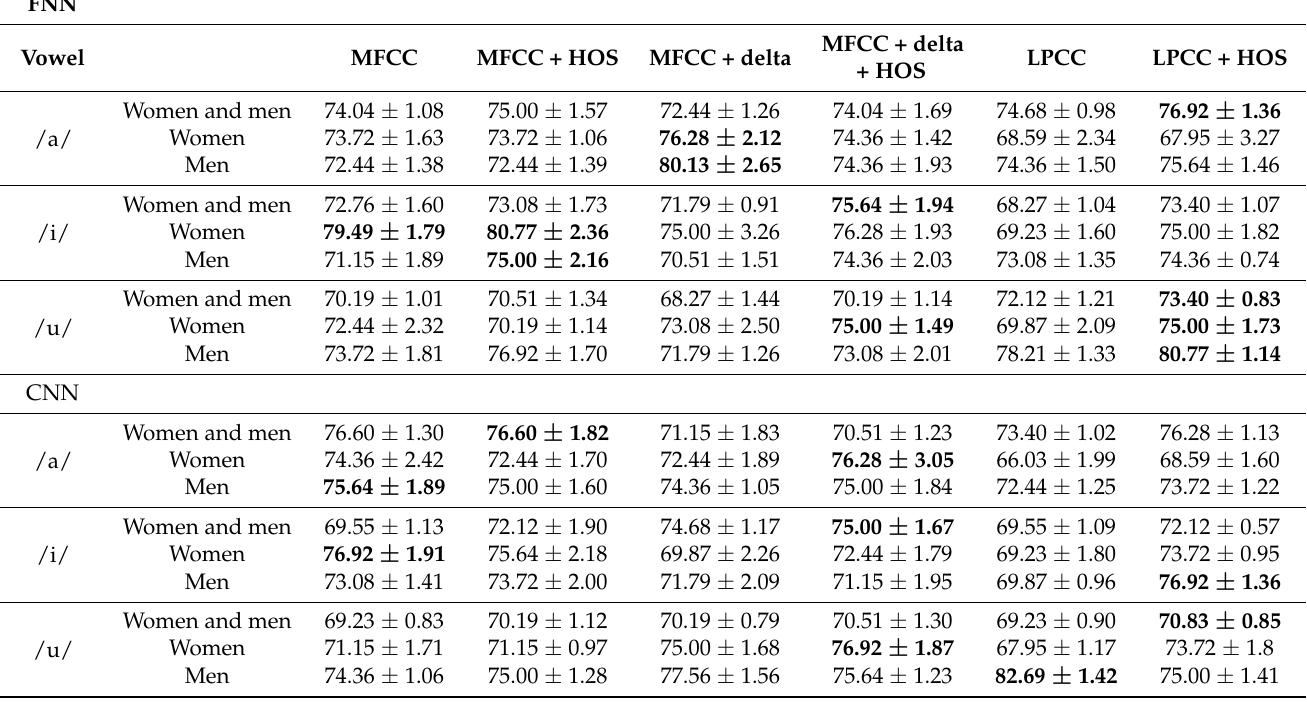
Table 5. Classification results obtained by various parameters and deep learning methods focused on sex and individ- ual